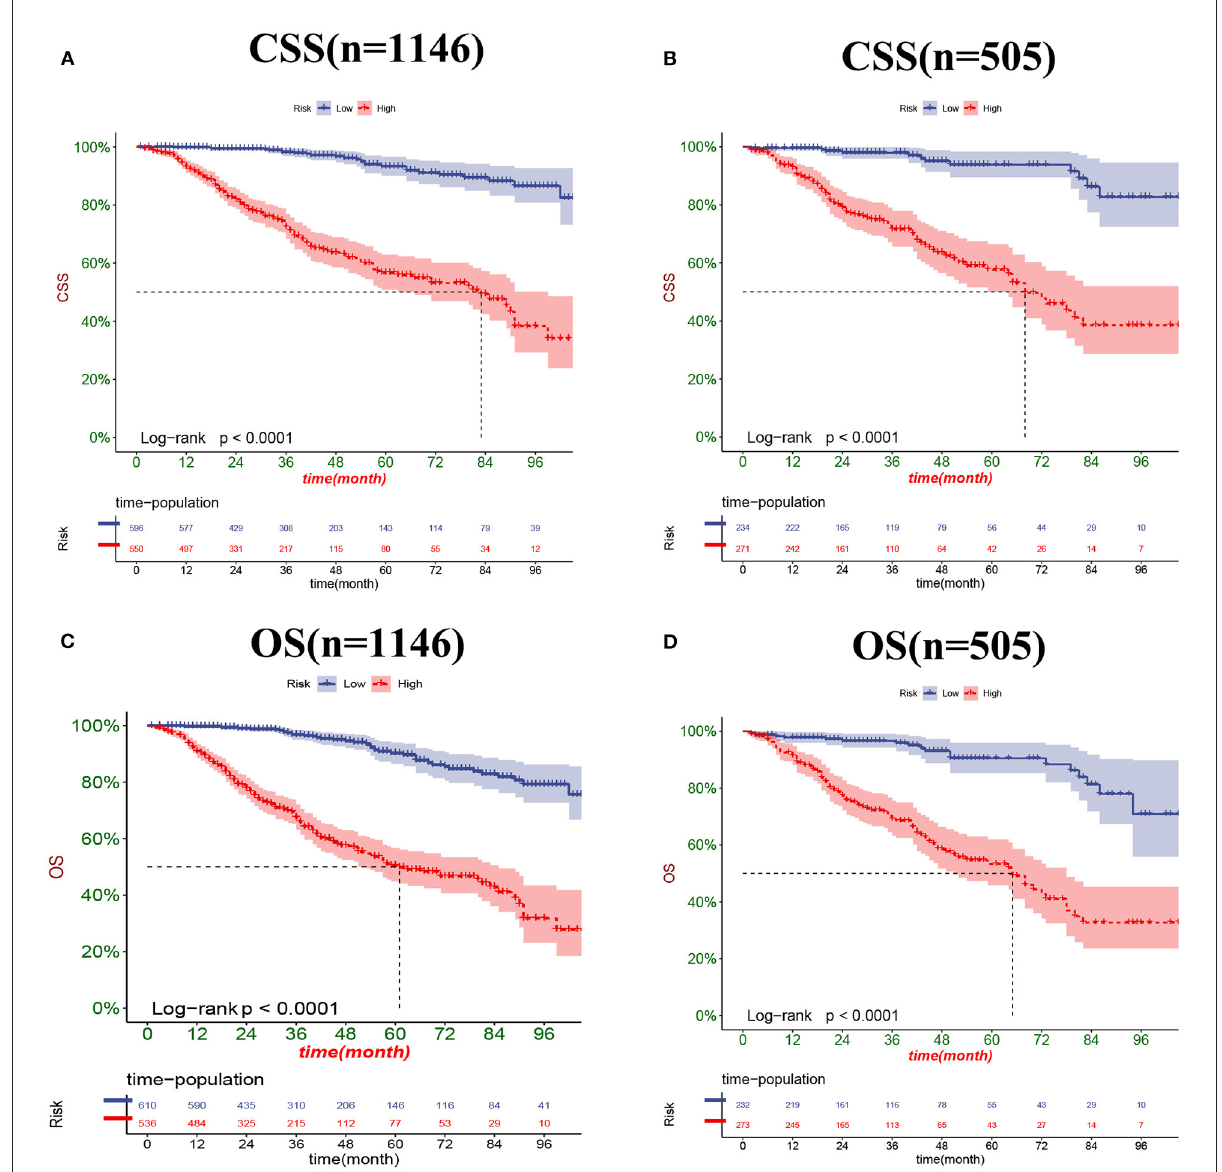
FIGURE6 Kaplan-Meier curves for predicting CSS (A,B) and OS (C,D) of patients in the low-risk and high-risk groups.